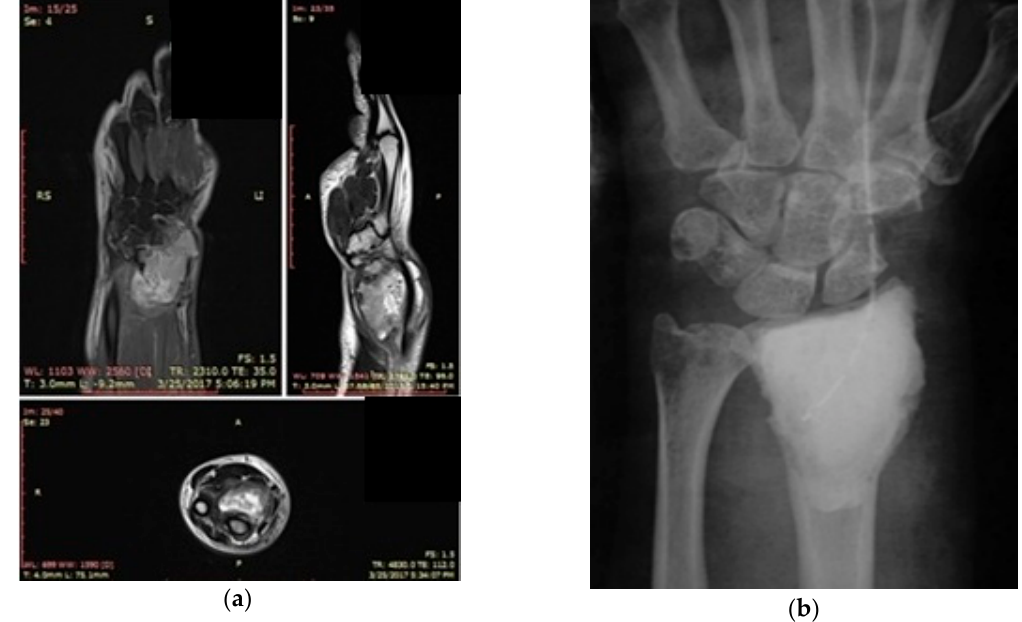
Figure 2. Case 2. ( a ) Preoperative MRI of the wrist joint (coronal, sagittal and axial) indicating GCT of distal radius. ( b ) Radiological exam of the wrist joint (AP view) one year after surgery reveals no sign of recurrence.